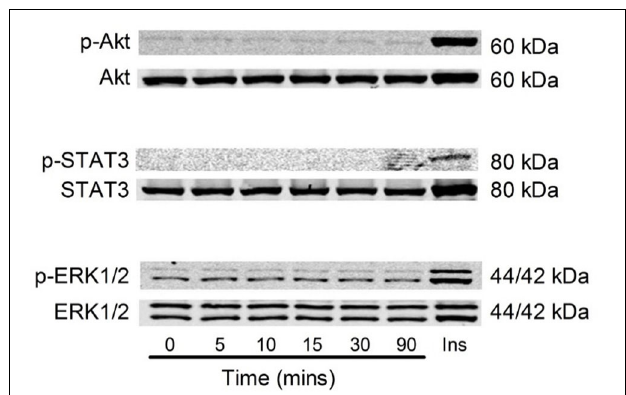
FIGURE 9 | Akt, STAT3 and Erk1/2 phosphorylation with 40ng/ml G-CSF in C2C12 myoblasts. Representative images of Akt, STAT3, and Erk1/2 phosphorylation following stimulation with G-CSF (40ng/ml) from 5 to 90min. 20 μ l G-CSF was added to the media at time 0min. Time zero represents 4h after serum free media was added to the cells. Ins = C2C12 myoblast treated with 100 μ M insulin for 15min using the spike in technique ( n = 3).